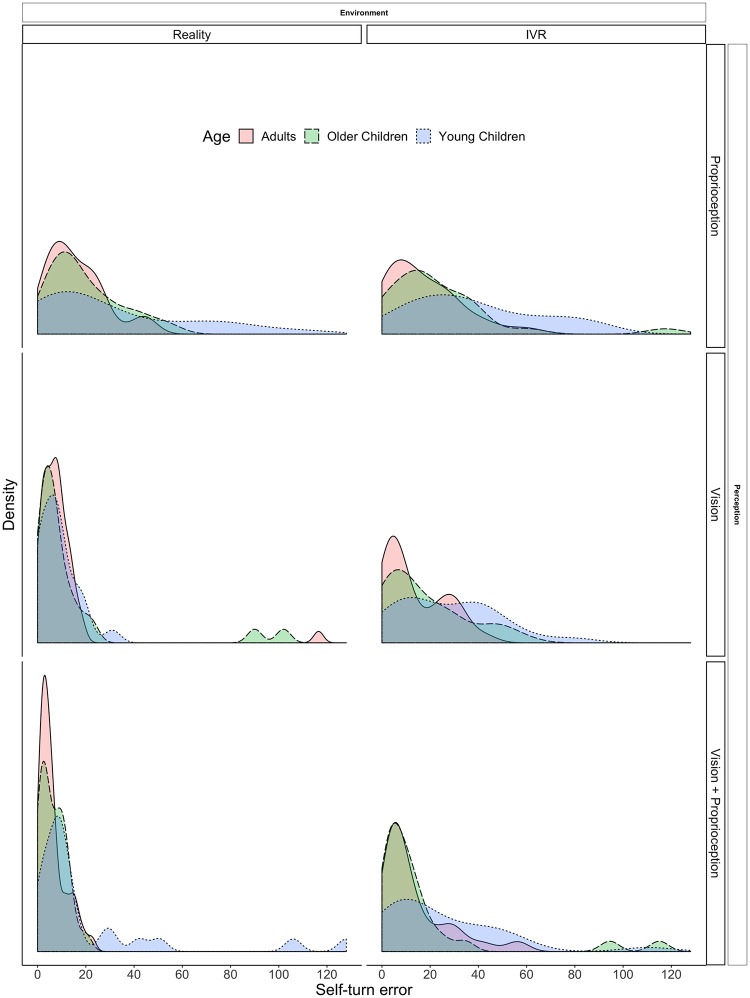
Estimated distributions of the observed self-turn errors in the different conditions according to age.(nparticipants = 49; nobservations = 578).